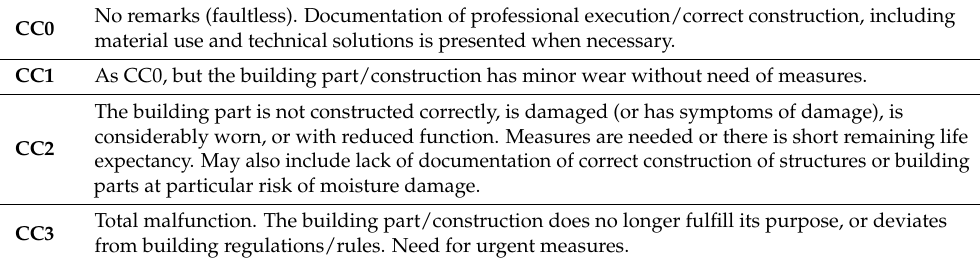
Table 1. Definition of condition grades (CCs) used in the building inspection